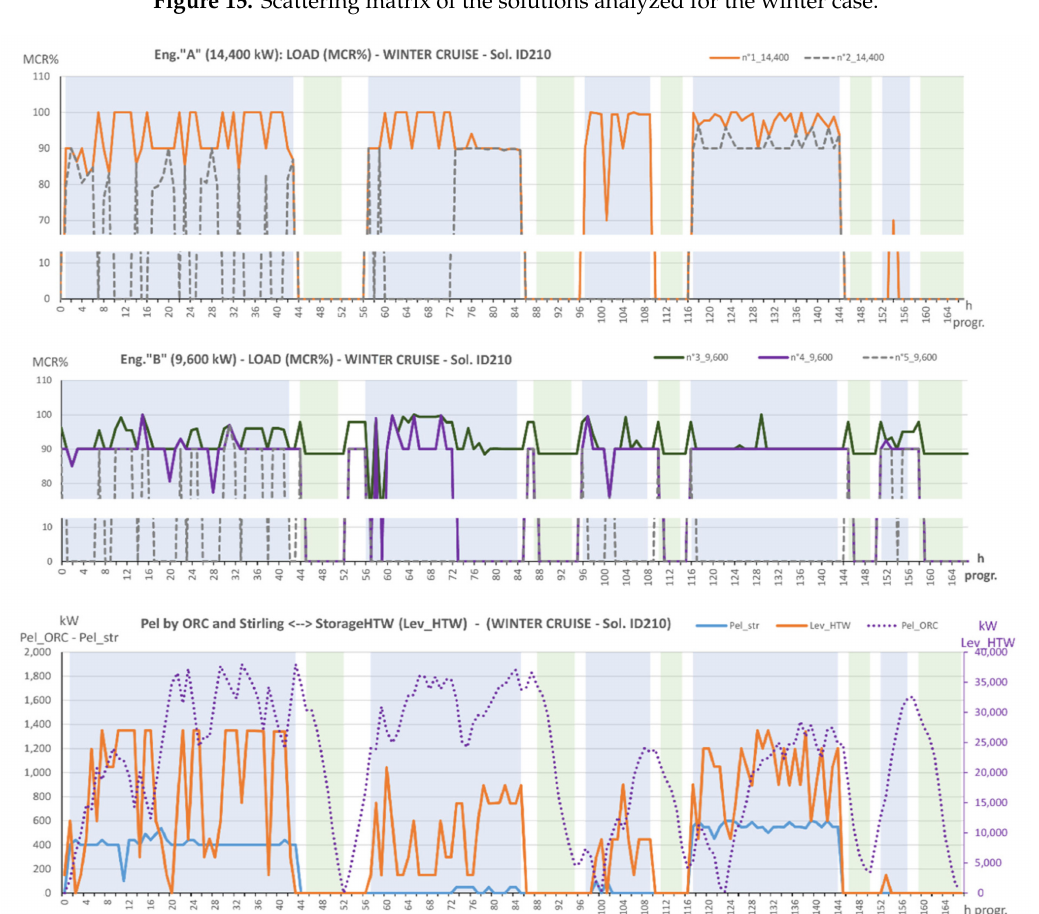
Figure 16. Results for the optimized management of the ID 210 solution (winter